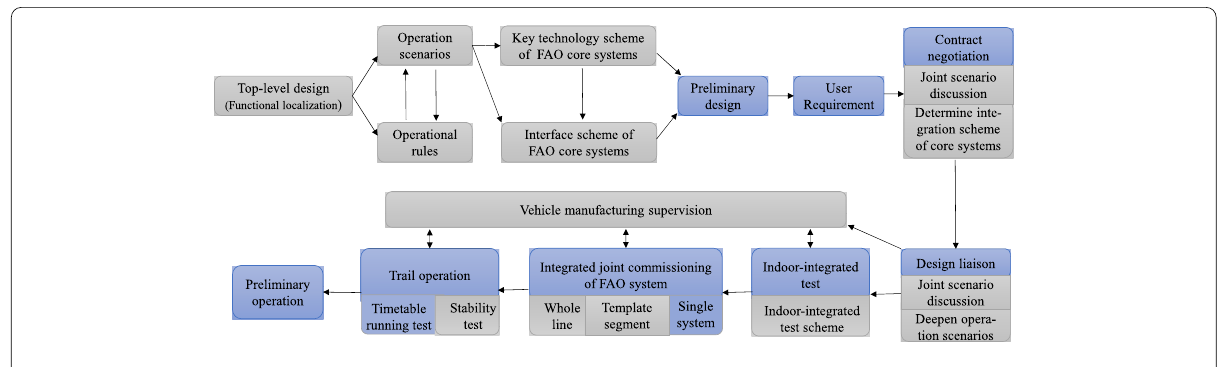
Figure 8 Construction management process of FAO